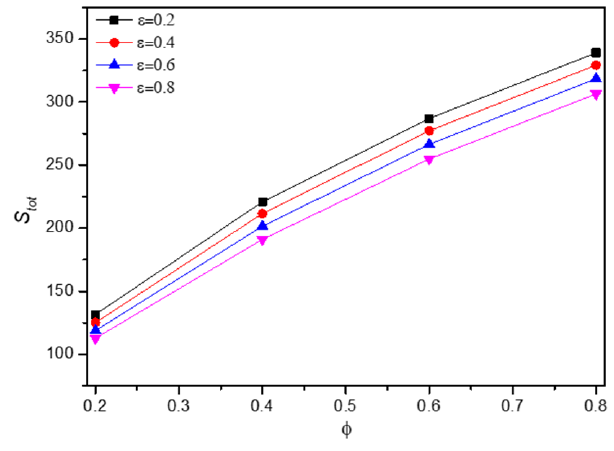
Figure 15. Total entropy as a function of solid volume fraction ( φ ) at various values of porosity ε p . Ra = 10 6 , Ha = 0, and Da = 0.01.